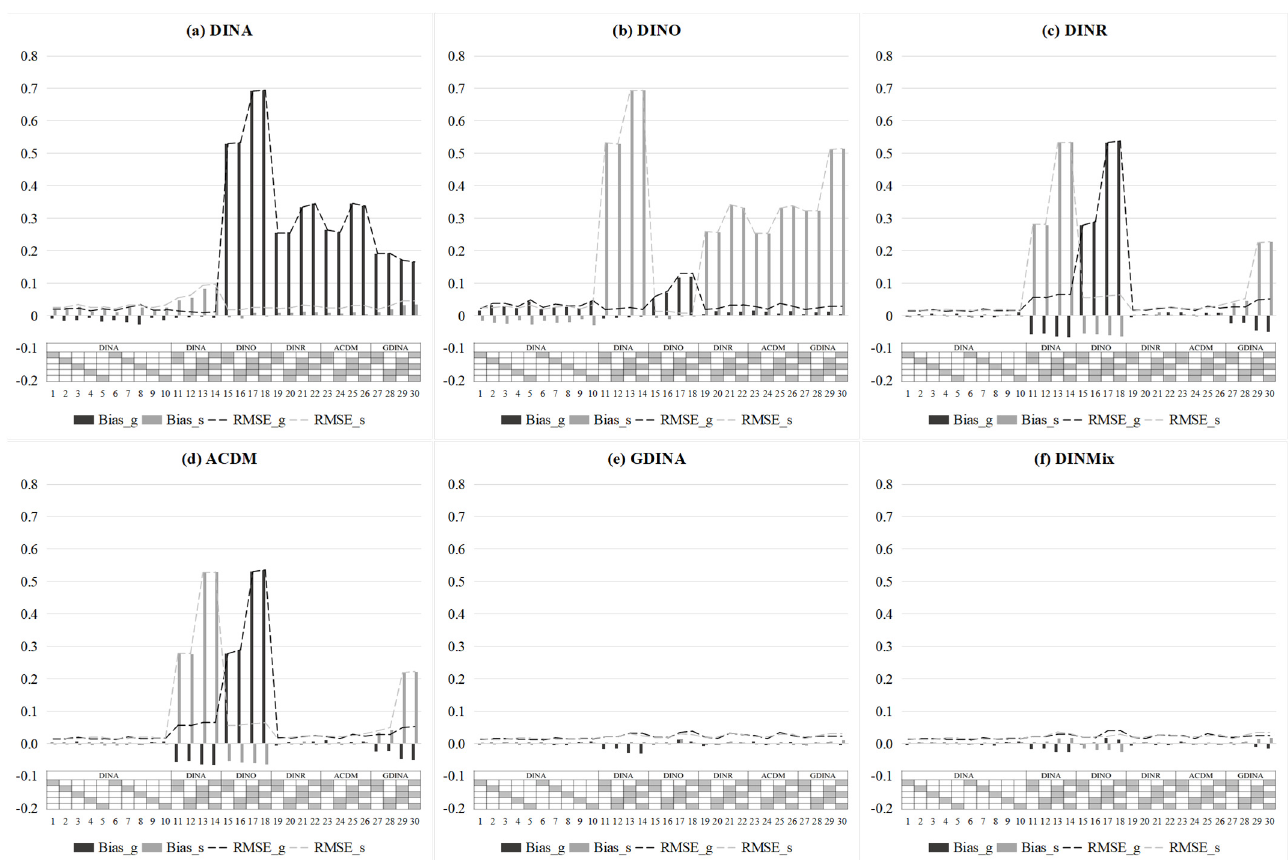
Figure 6. Summary of the recovery of item parameters in simulation Study 2. Note, RMSE = root mean square error; DINA = deterministic input, noisy ‘and’ gate model; DINO = deterministic input, noisy ‘or’ gate model; DINR = deterministic input, noisy ratio model; ACDM = additive cognitive diagnosis model; GDINA = generalized DINA model; DINMix = deterministic input, noisy mixed model.